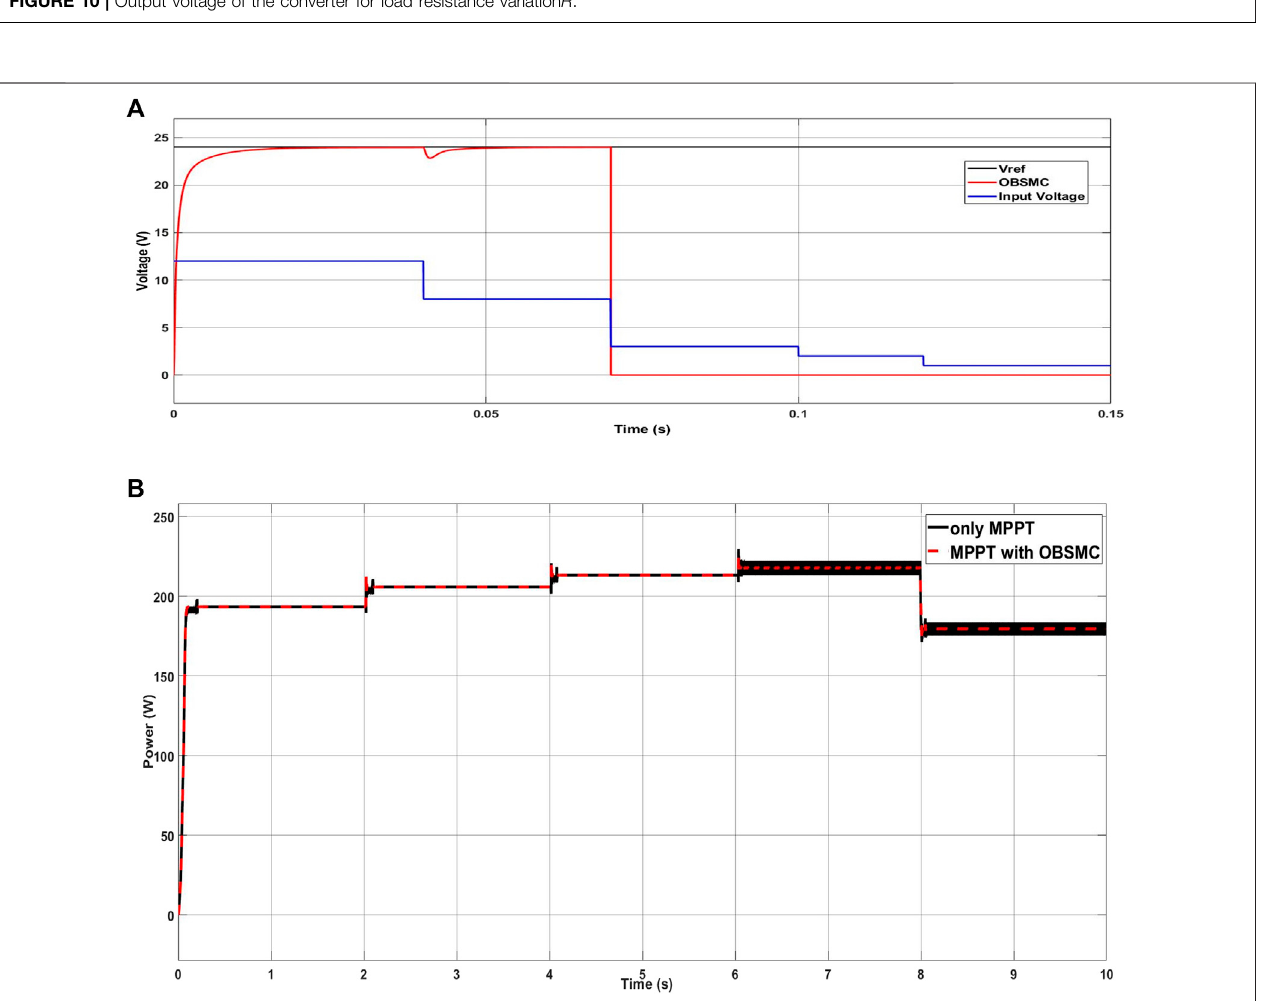
FIGURE 11 | Output of the converter for (A) ef fi cient operation and (B) for MPPT implementation.